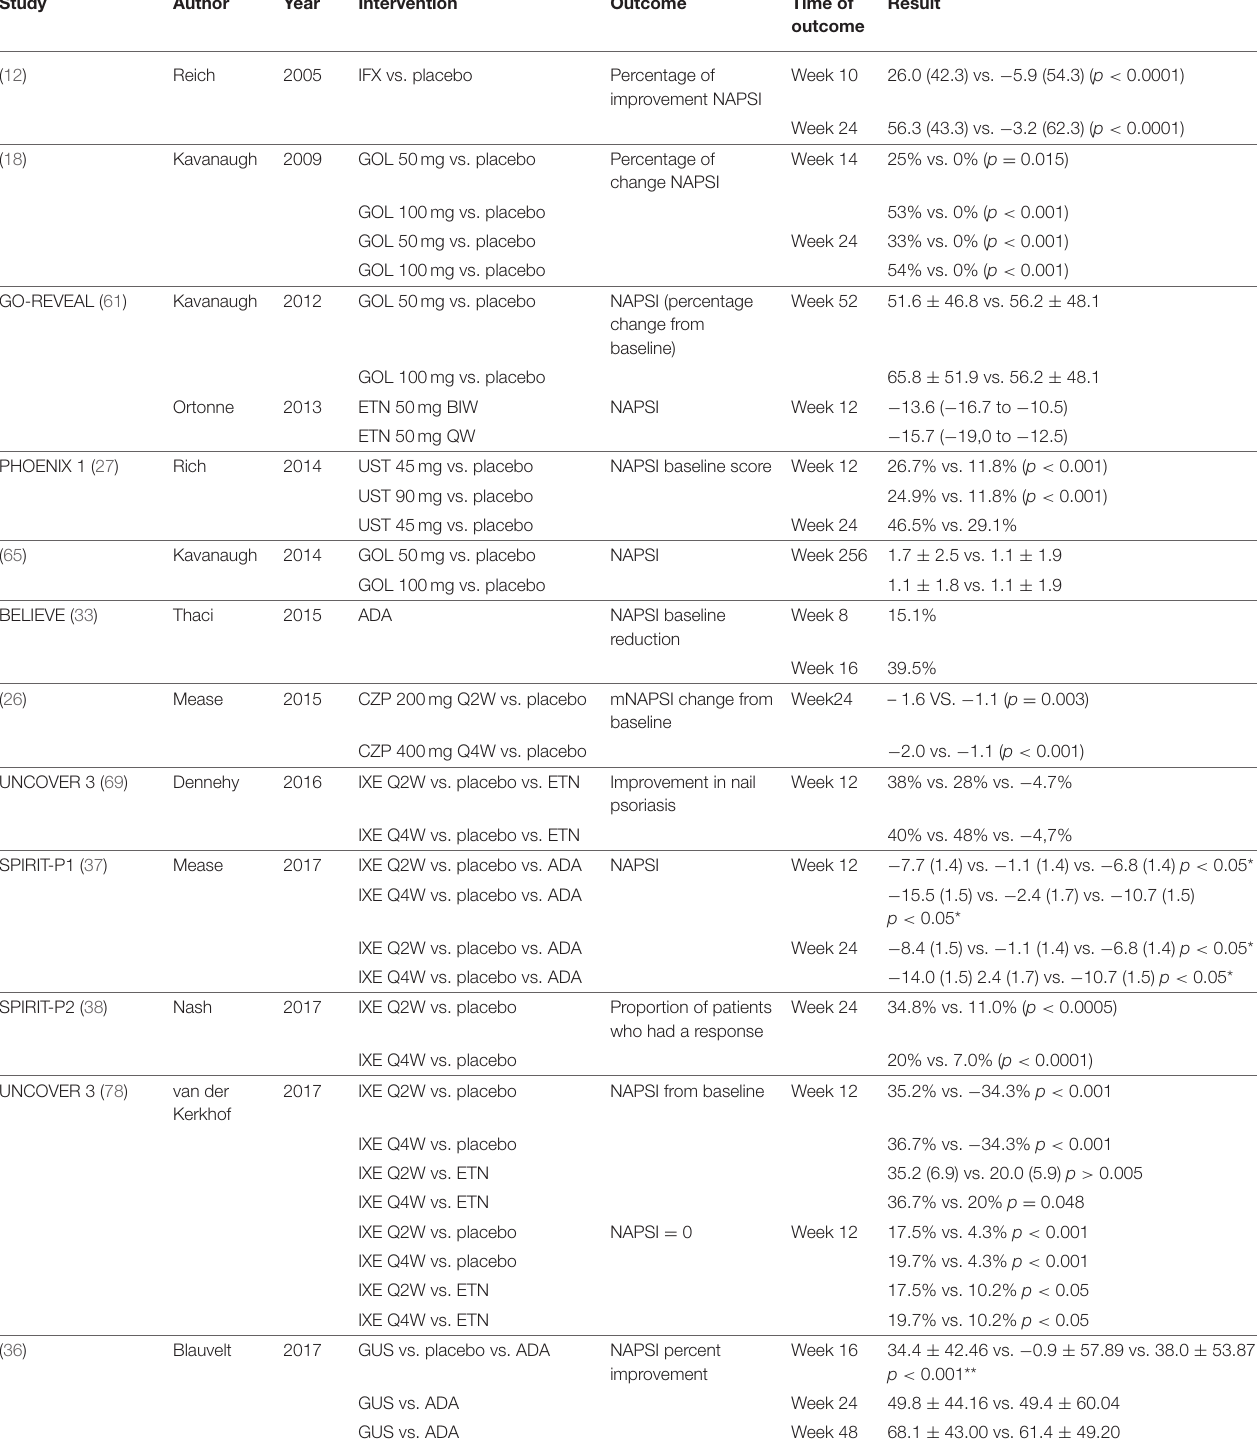
TABLE 9 | Nail psoriasis assessment in patients with psoriasis.